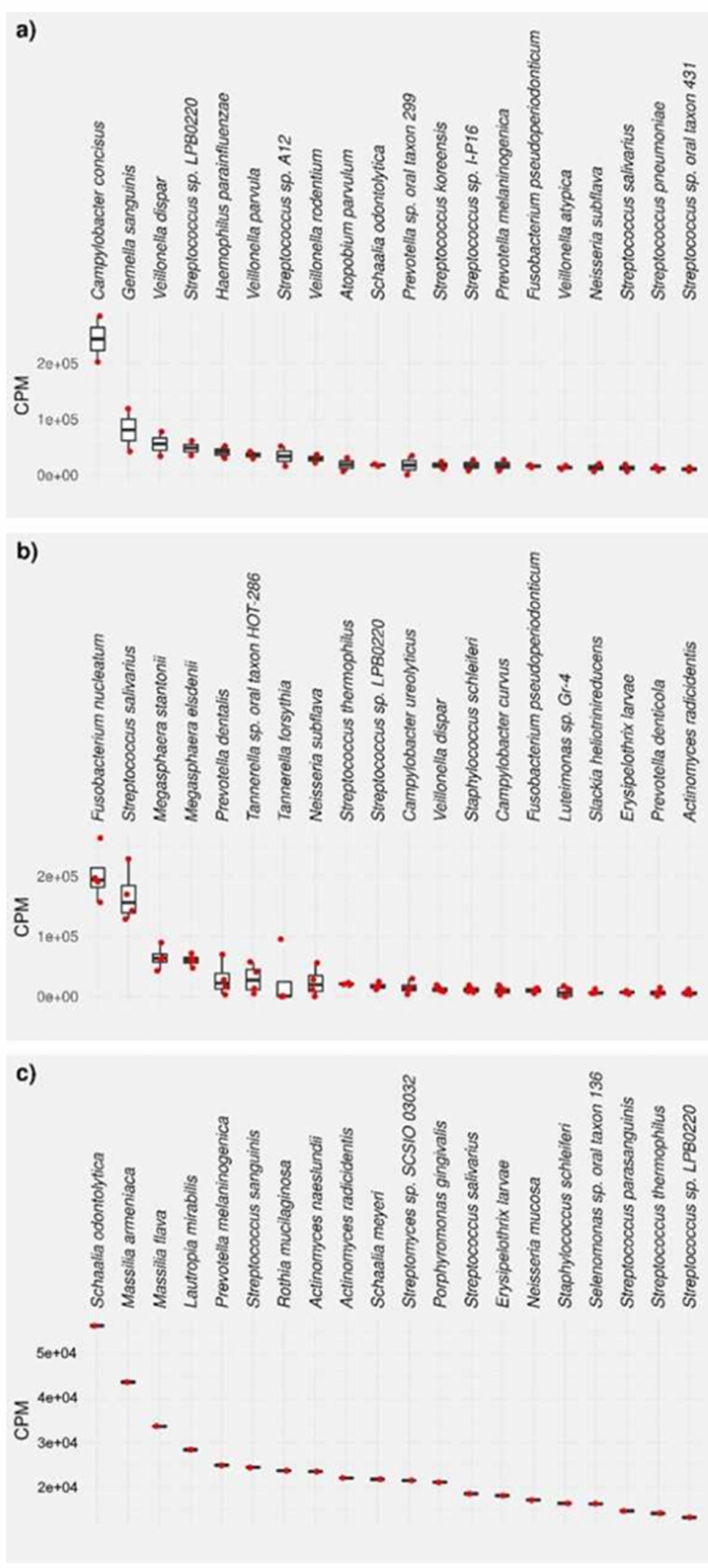
Figure 4. Top 20 most abundant bacterial species, presented as CPM, for ( a ) bacteria found in saliva, ( b ) bacteria harvested from native biofilms grown on uncoated substrates, and ( c ) bacteria harvested from biofilms grown on uncoated substrates to which the disinfectant chlorhexidine digluconate (CHX) had been